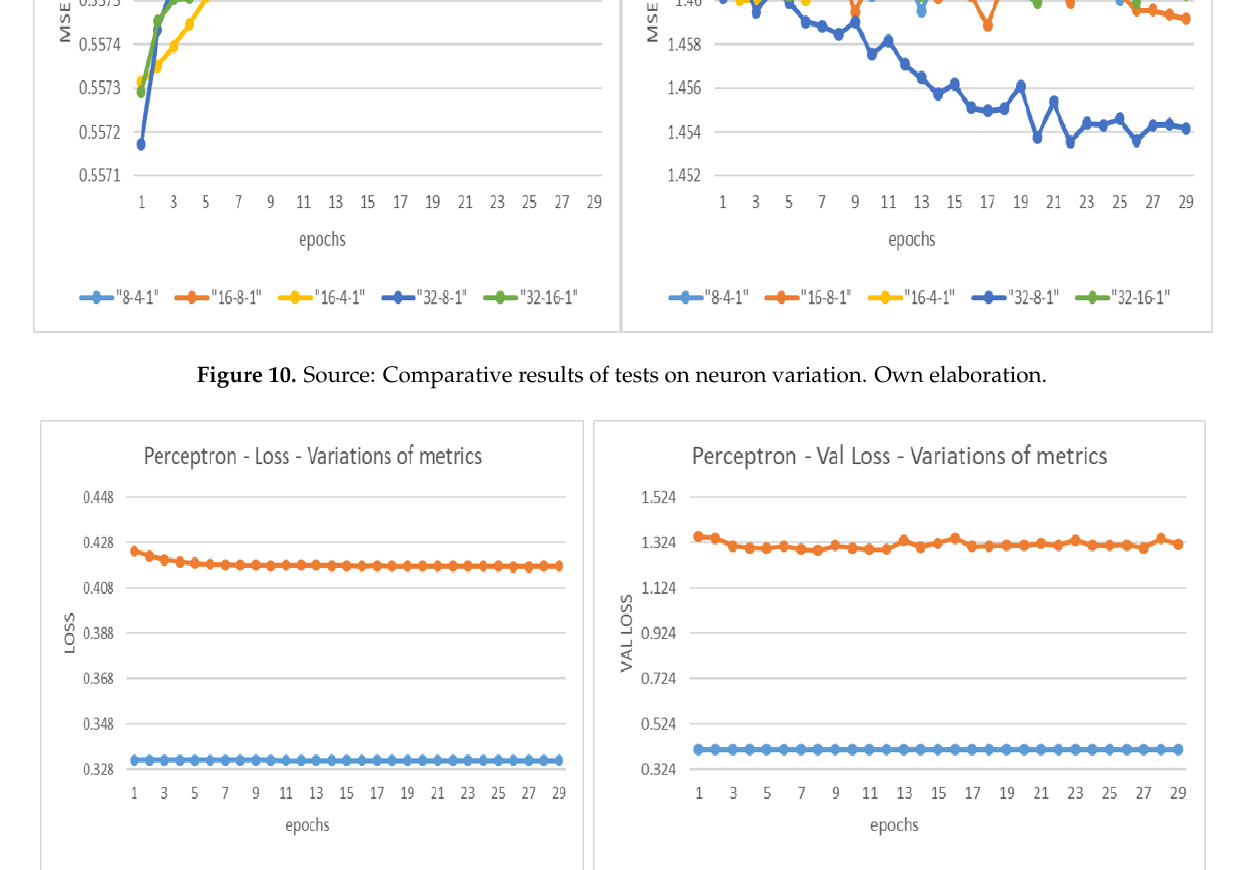
Figure 10. Source: Comparative results of tests on neuron variation. Own elaboration.